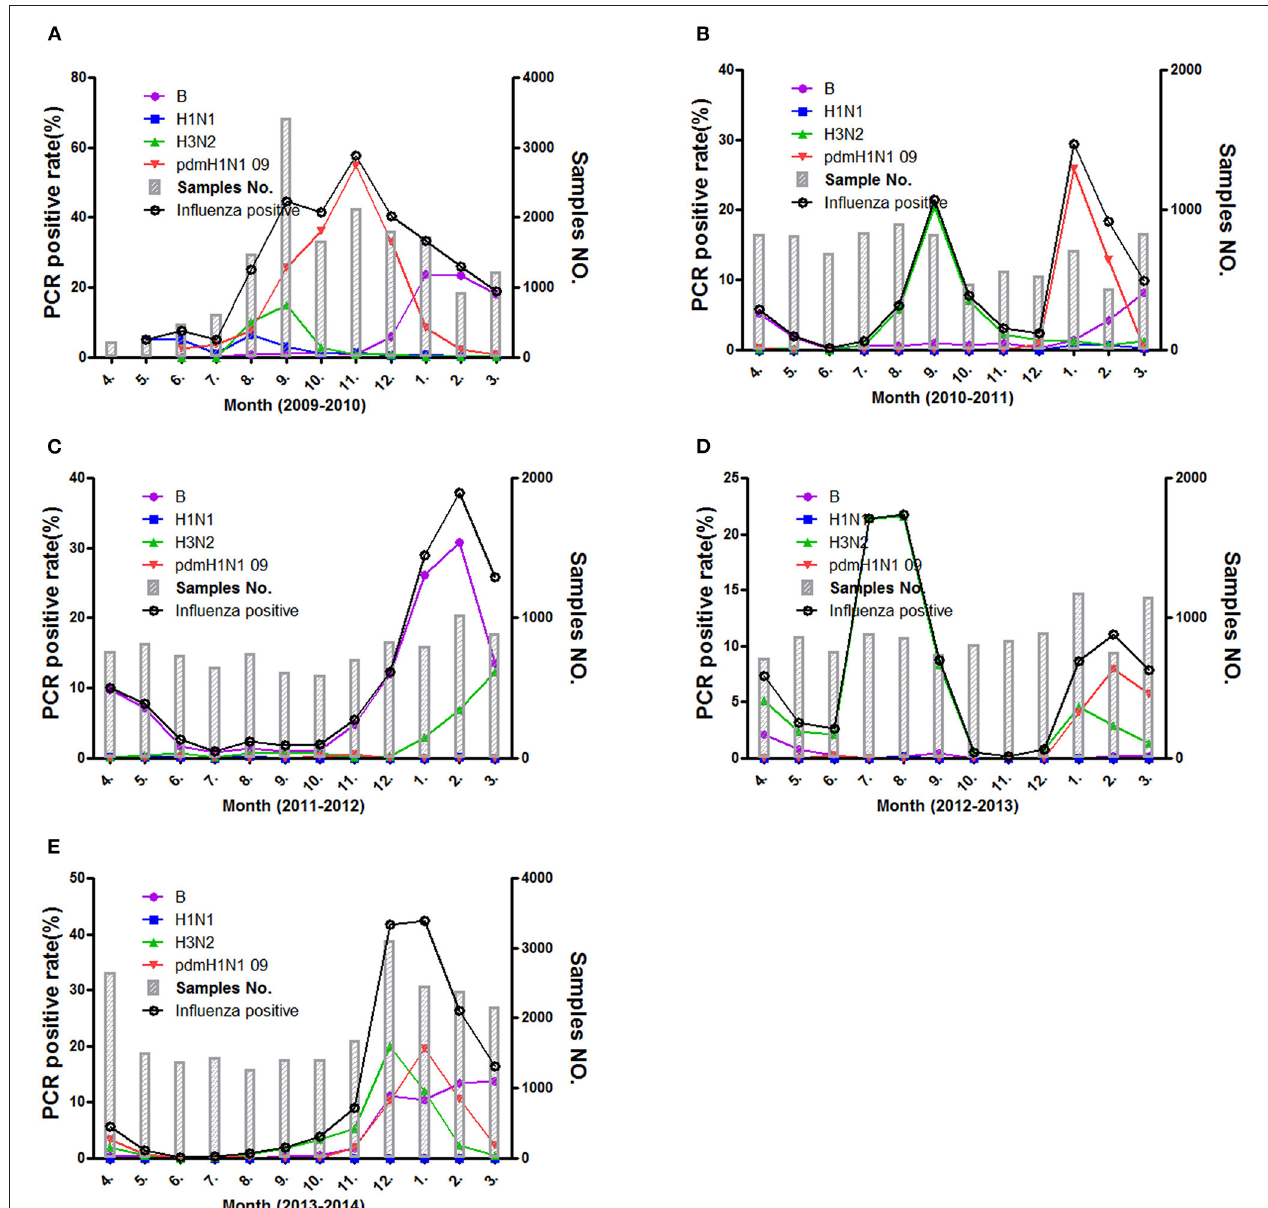
FIGURE 2 | The positive rate of different influenza subtypes during the different surveillance years (A–E) from 2009 to 2014.